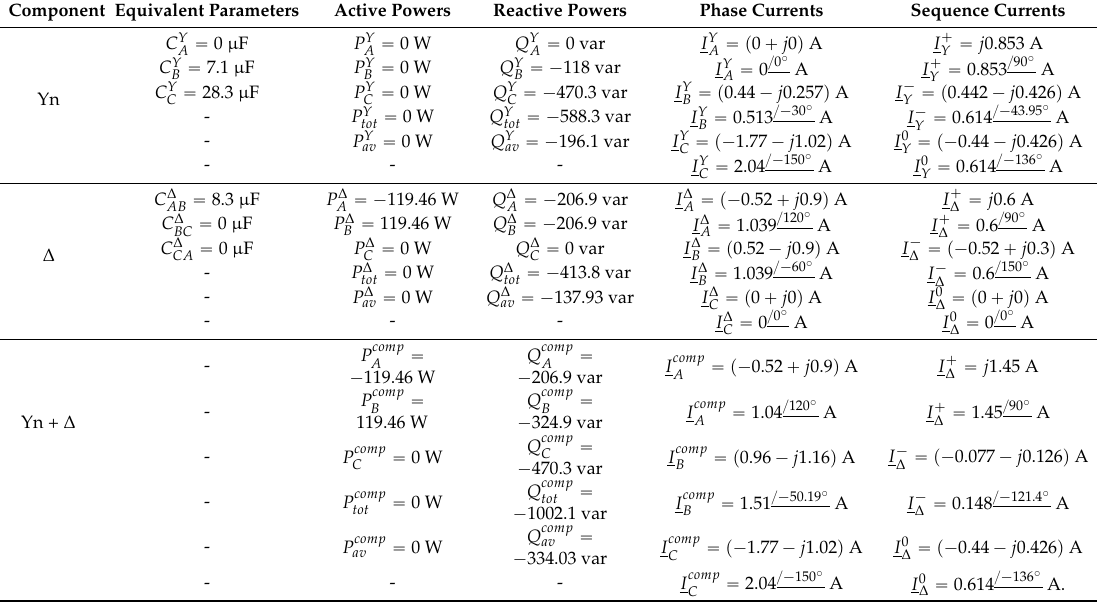
Table 3. The unbalanced compensator sized using version 5(3) (Balancing Capacitive Compensator (BCC)). Component Equivalent Parameters